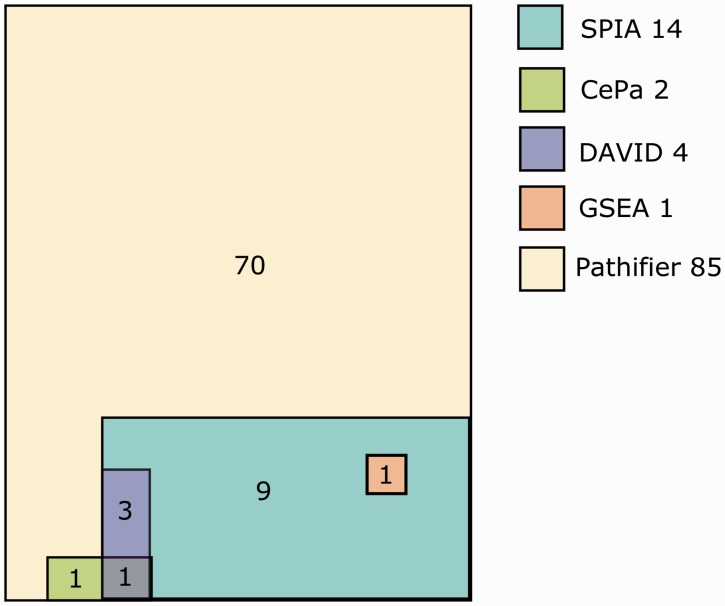
Number of overlapping pathways detected by different methods from ccRCC data set GSE14994. NetGSA results were excluded because it did not detect any pathways significant from that data set. The total numbers of detected significant pathways are indicated after the method names. In total, 86 pathways were tested. A colour version of this figureis available at BIB online: http://bib.oxfordjournals.org.